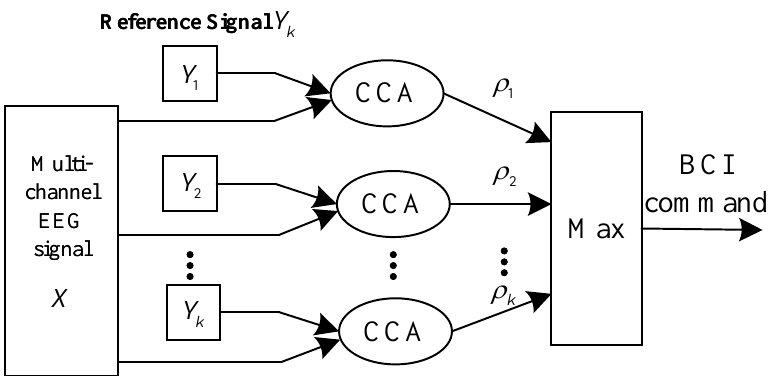
Figure 3. Process of CCA in EEG signal